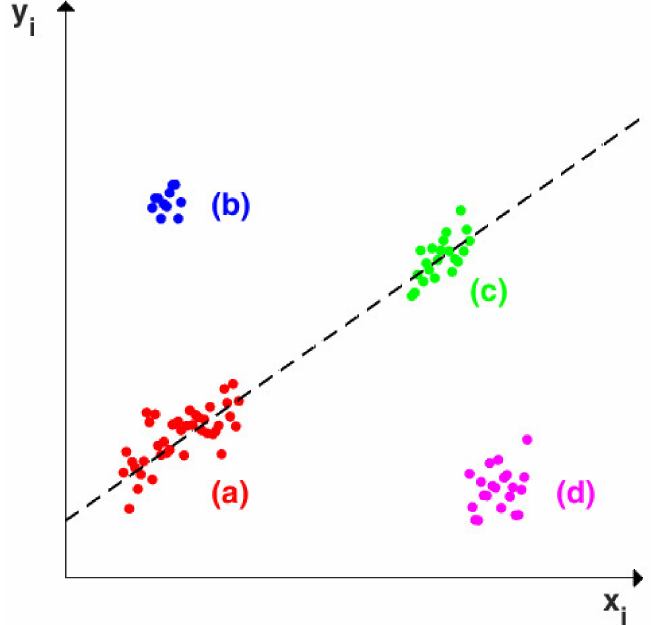
Figure 1. Example of simple linear regression showing (a) regular observations, (b) vertical outliers, (c) good leverage points, (d) bad leverage